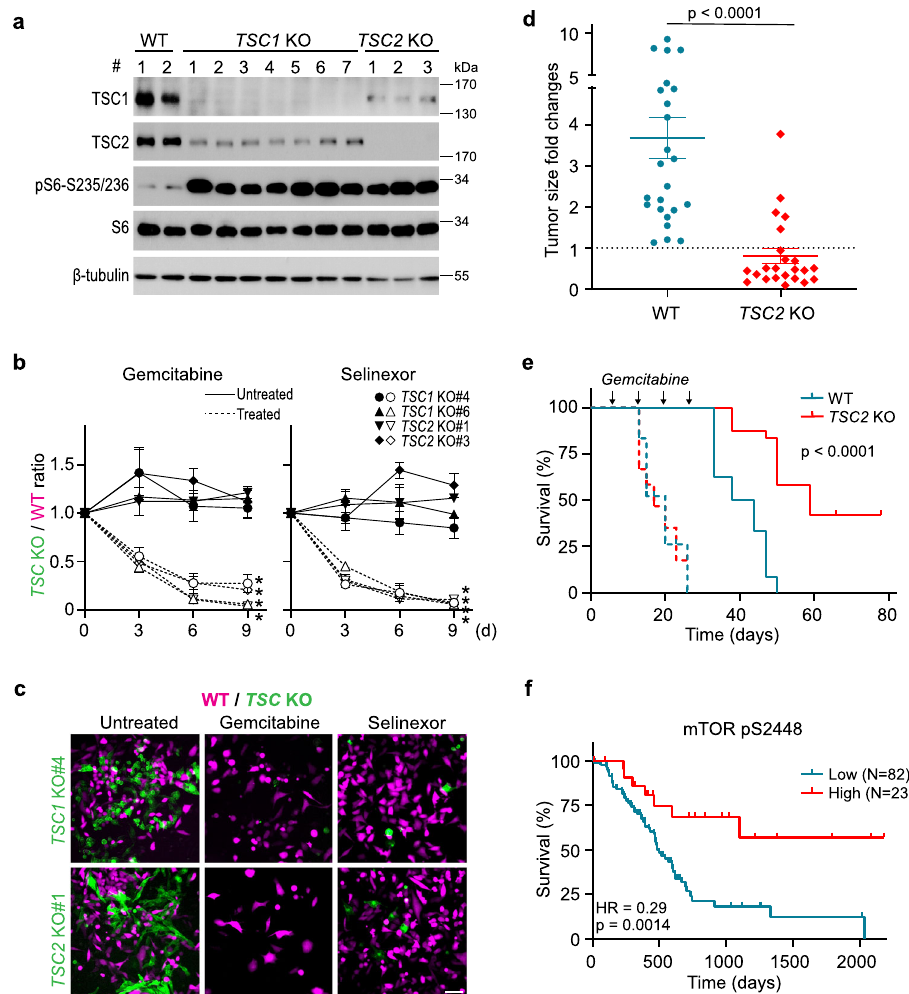
Fig.3|mTORactivationconferschemosensitivityinvitroandinvivo.a Western analysisof single-cell clones of TSC1 and TSC2 knockouts derivedfrom MIA